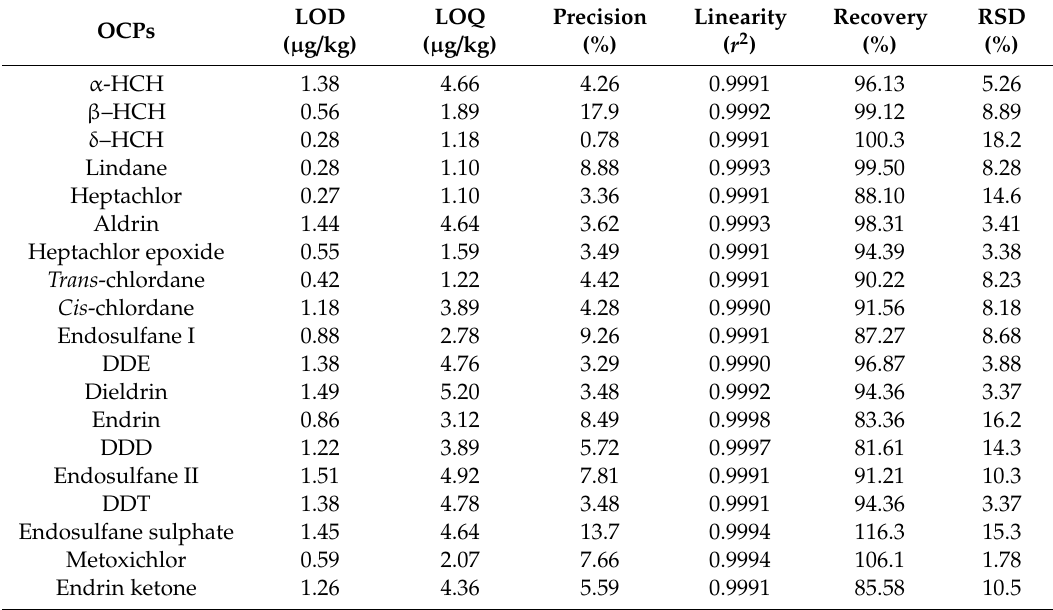
Table 3. The average values of LOD, LOQ, precision, linearity, recovery and RSD in blank smoked meat samples, spiked with 50 µ g / kg ( n = 20).